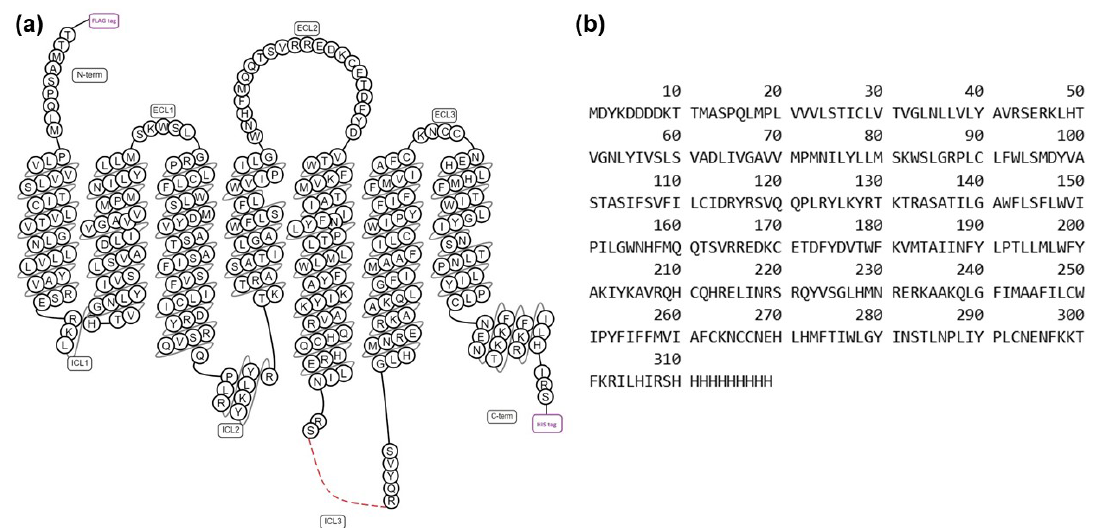
Figure 1. Design of a human H 1 R amino acid sequence for NMR studies. ( a ) Snake plot of the H 1 R receptor employed in the current study, as generated from the GPCRdb [31] . The red dashed line represents residues from the third intracellular loop that have been truncated from the native sequence. The “tag” labels at the N-terminus and C-terminus represent a FLAG tag and polyhistidine tag, respectively; ( b ) amino acid sequence of the human H 1 R employed in this